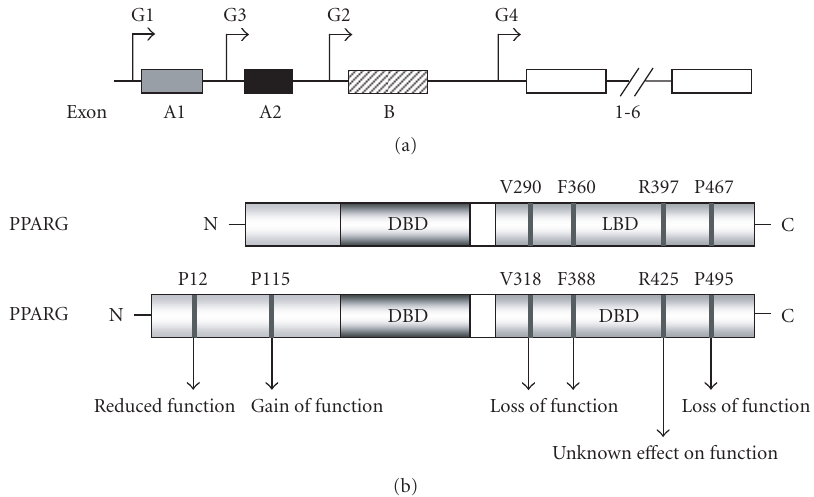
Figure 2: (a) The genomic structure of the 5 (cid:2) end of the human PPARG gene. Exons 1-6 are common. Exons A1 and A2 are untranslated, and exon B is translated, giving rise to two di ff erent proteins corresponding to the G1 or G2 transcripts. (b) The domain structure of PPARG1 and G2 isoforms with the positioning of mutations or polymorphisms resulting in substituted amino acid residues, and altered protein functions. DBD, DNA-binding domain; LBD, Ligand-binding domain. (Figure adapted from Sundvold and Lien[33], Tsai and Maeda [37], and Stumvoll and H¨aring